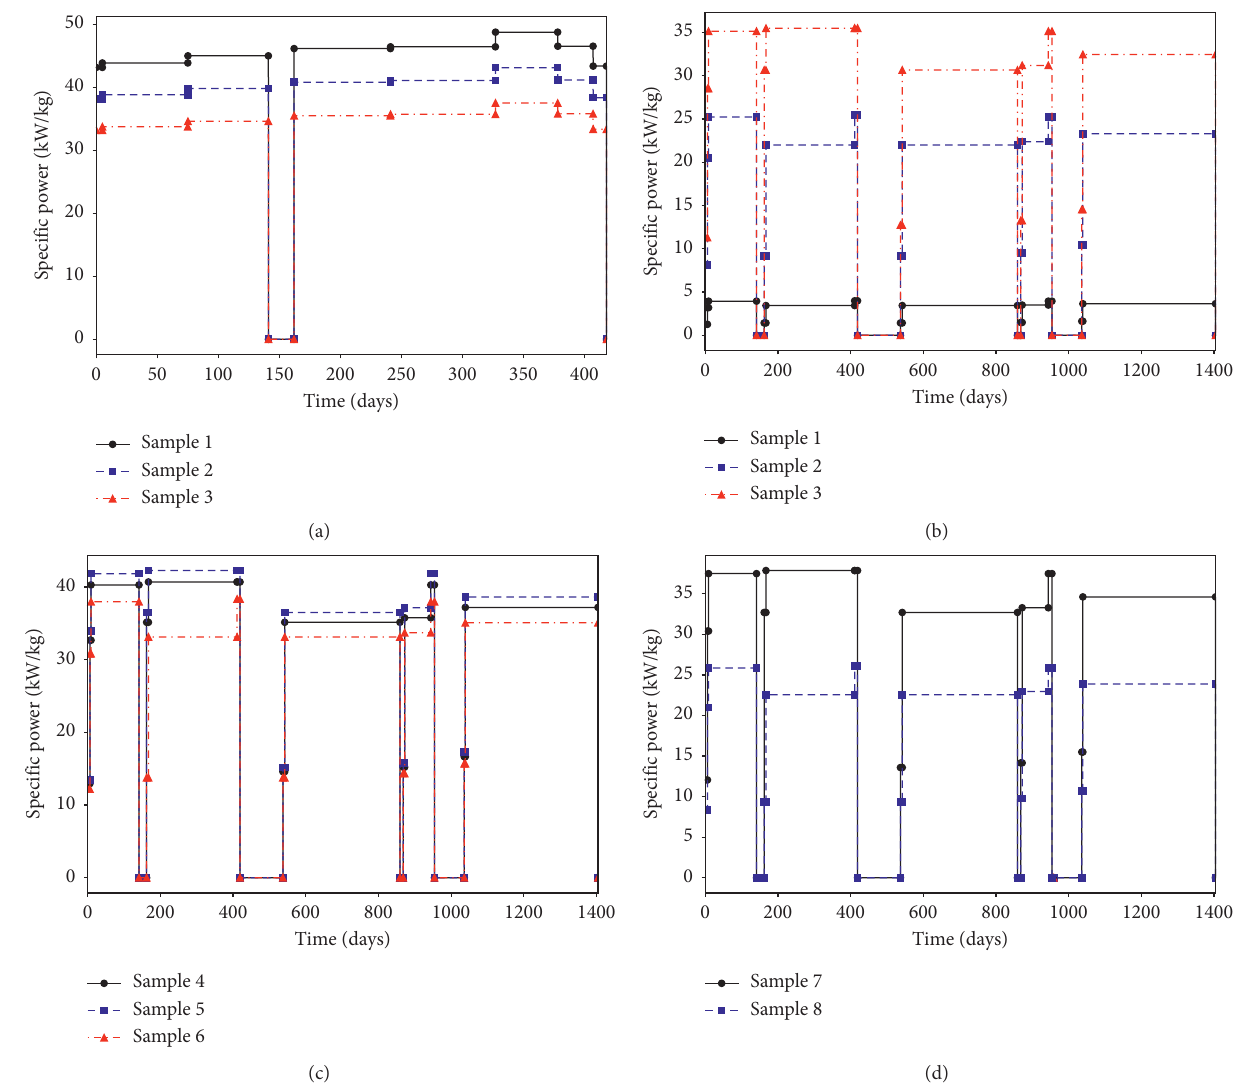
Figure 4: Sample power history for 2F2D1 assembly (a) and 2F2DN23 (b–d). (a) 2F2D1/F6. (b) 2F2DN23/SF98 (samples 1–3). (c) 2F2DN23/SF98 (samples 4–6). (d) 2F2DN23/SF98 (samples